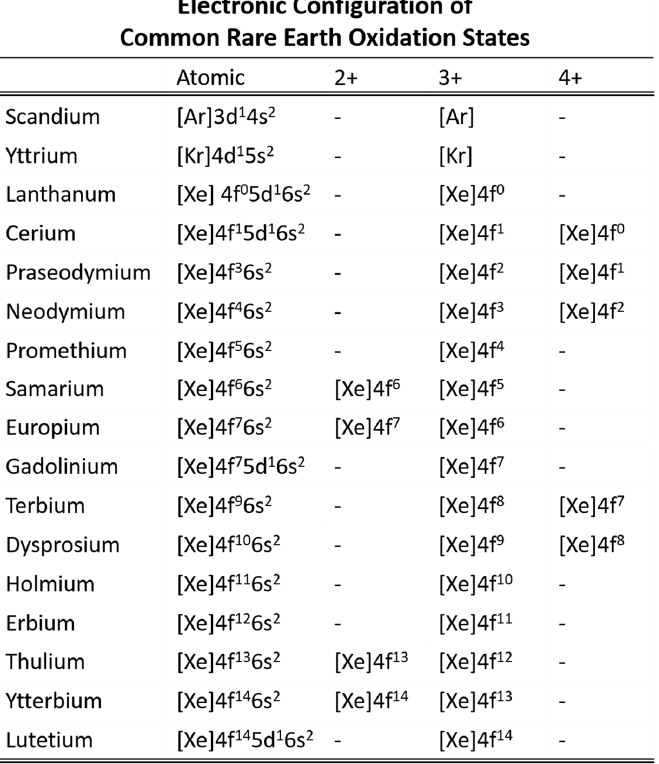
Figure 4. Electron configuration of the REE cations (adapted from Gupta [15]).